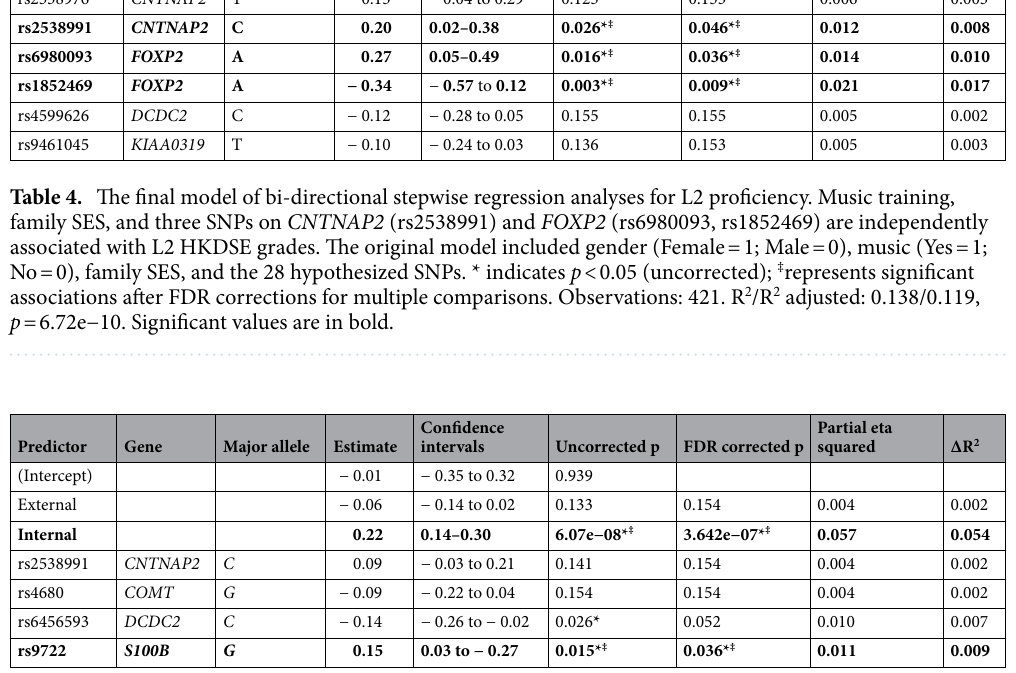
Table 5. The final model of bi-directional stepwise regression analyses for L3 proficiency with motivation variables included as additional predictors. Internal motivation and S100B (rs9722) are independently associated with L3 Global Scores. The original model included gender (Female = 1; Male = 0), music training (Yes = 1; No = 0), family SES, external motivation, internal motivation, attitude, and anxiety, and 28 SNPs. * indicates p < 0.05 (uncorrected); ‡ represents significant associations after FDR corrections for multiple comparisons. Observations: 510. R 2 /R 2 adjusted: 0.088/0.077, p = 2.614e−08. Significant values are in